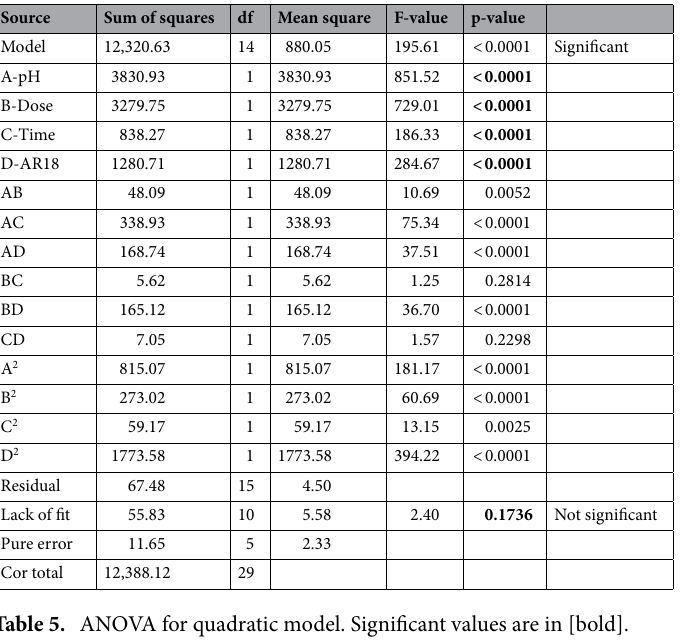
Table 5. ANOVA for quadratic model. Significant values are in [bold].